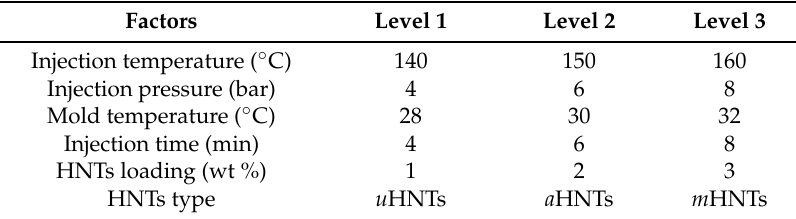
Table 2. The parameters for three levels of the selected factors [30,31].